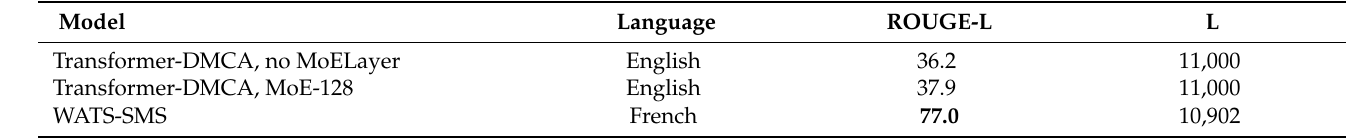
Table 5. Comparison with other abstractive models (length up to 500